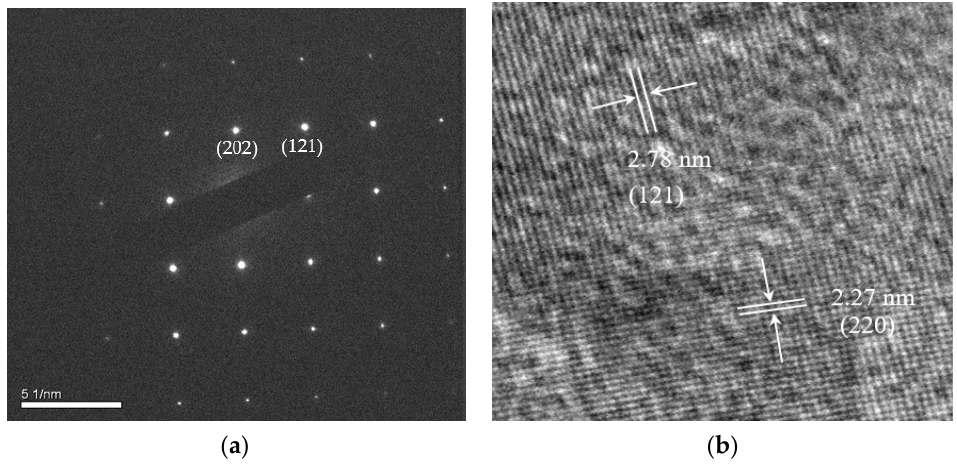
Figure 5. ( a ) TEM-associated SAED pattern and ( b ) HRTEM imageof Pr-LaFeO 3 .